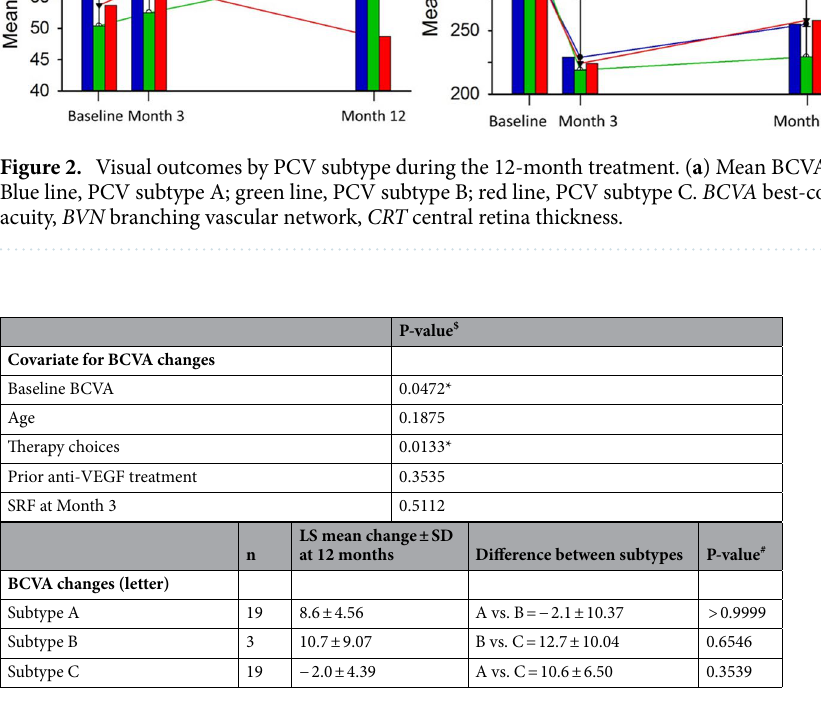
Table 3. Adjusted changes in BCVA by PCV subtypes. SD standard deviation, LS least square, VEGF vascular endothelial growth factor, SRF subretinal fluid, BCVA best-corrected visual acuity. # ANCOVA was applied for the LS mean changes by considering the effects of baseline BCVA and all covariates (age, therapy choices, prior anti-VEGF treatment, and presence of SRF at 3